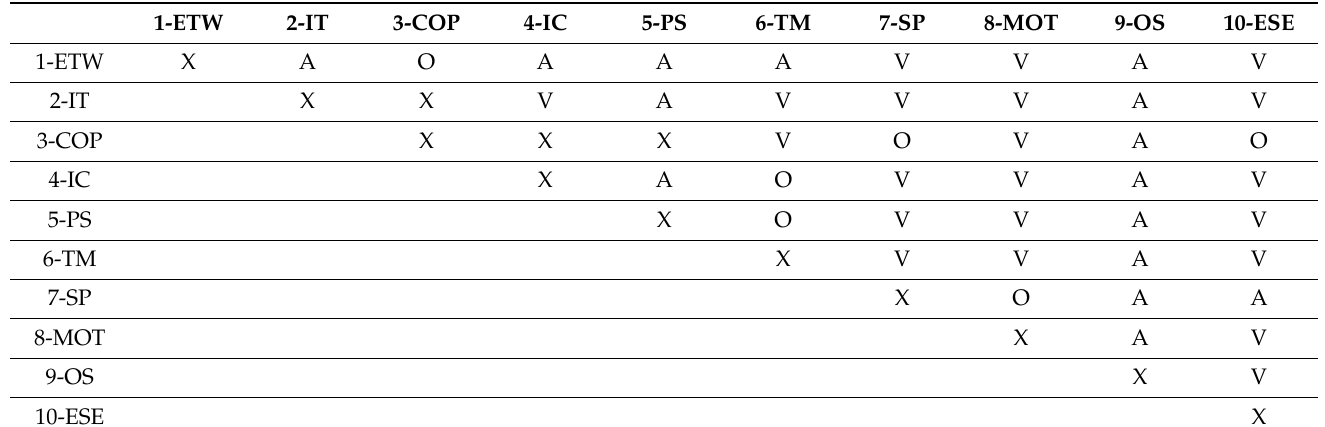
Table 1. Structural self-interaction matrix